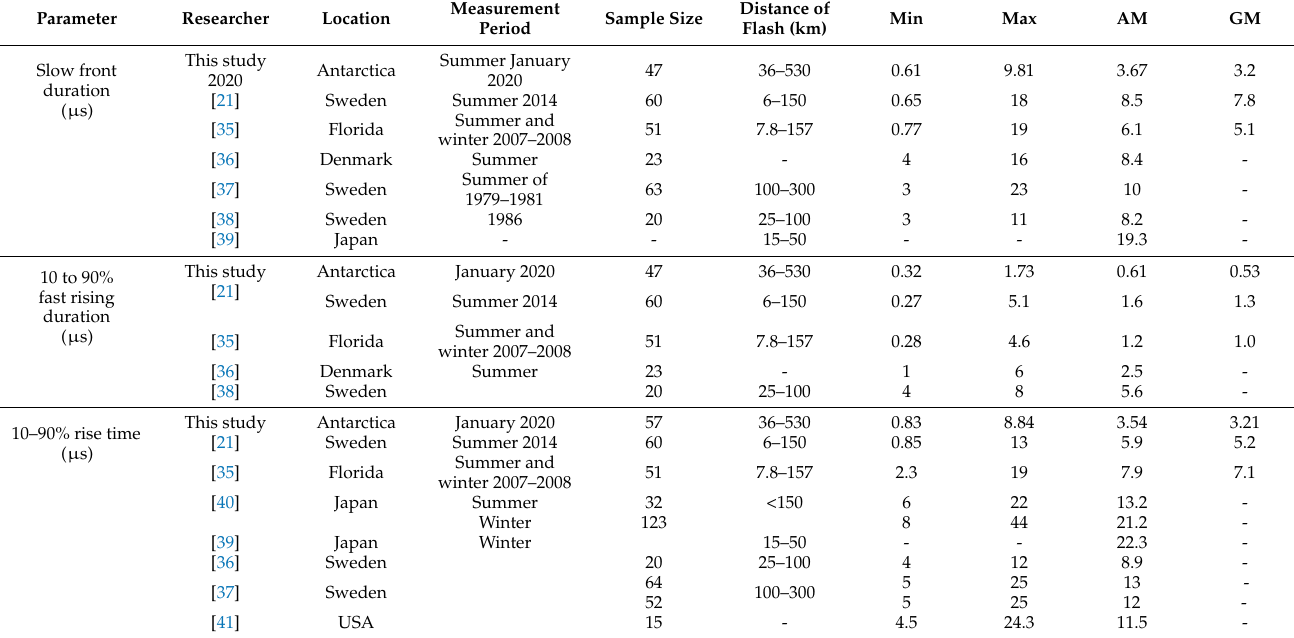
Table A6. Comparison on return strokes parameters between previous studies for +CG